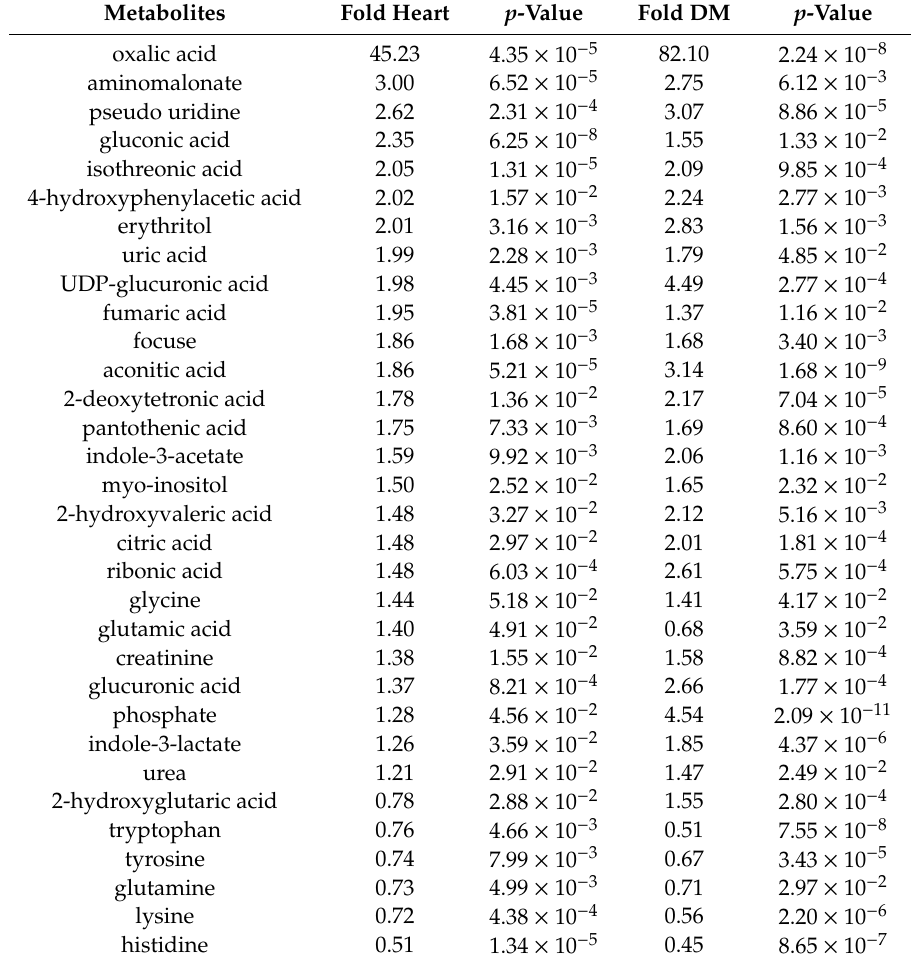
Table 1. Metabolites found to be significantly di ff erent in PAH cohort vs. heart or DM